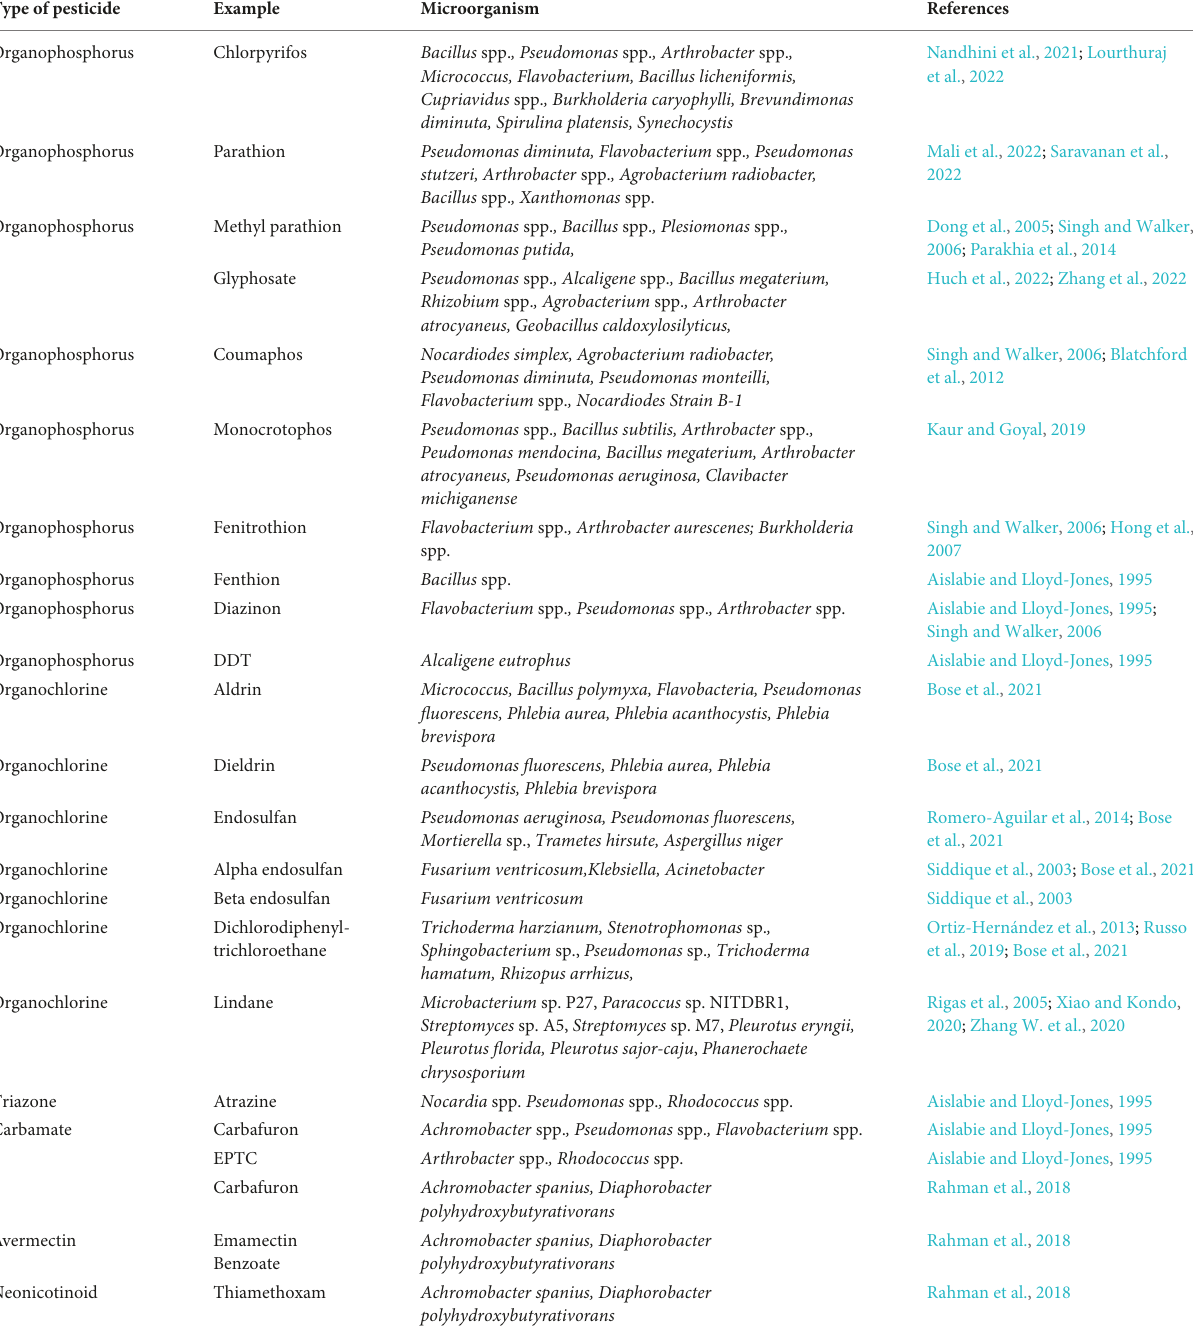
TABLE 6 Pesticides degrading